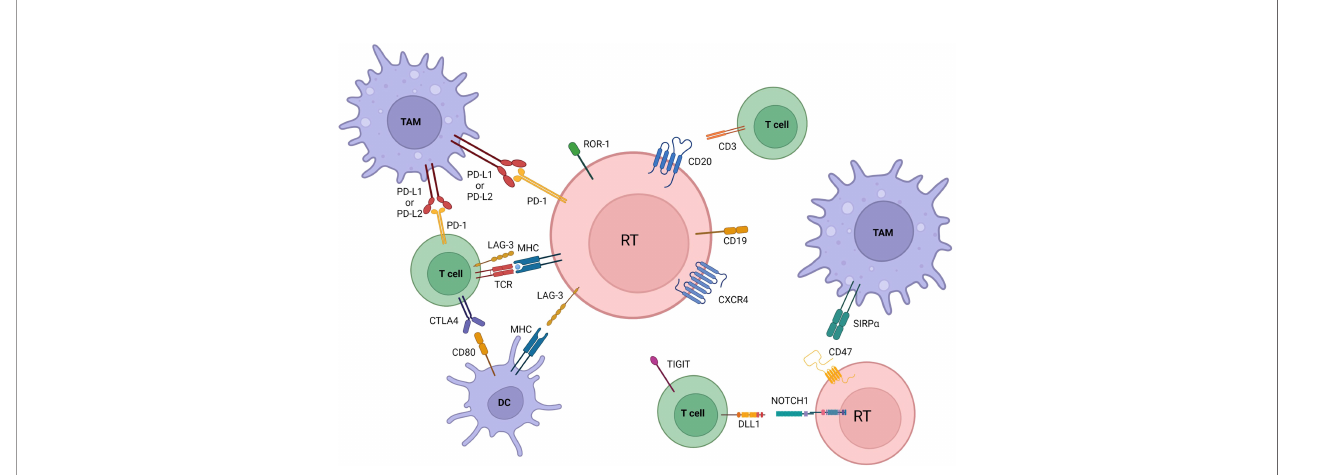
FIGURE 2 | Microenvironmental crosstalks and druggable targets in Richter transformation. Pathway activation and changes in immune checkpoints pro fi le are also involved in transformation. Communication between the tumoral cells, dendritic cells, tumor associated macrophages (TAM), and T cells is established by direct contact, chemokine/cytokine receptors, adhesion molecules and ligand-receptor interactions. Immune inhibitory molecules (PD-L1 among others) facilitate tumor cells to evade immune-response and maintain tolerance. All of the here represented are druggable targets in RT. BCR, B cell receptor; DC, dendritic cells; TAM, tumor associate macrophage. Created with